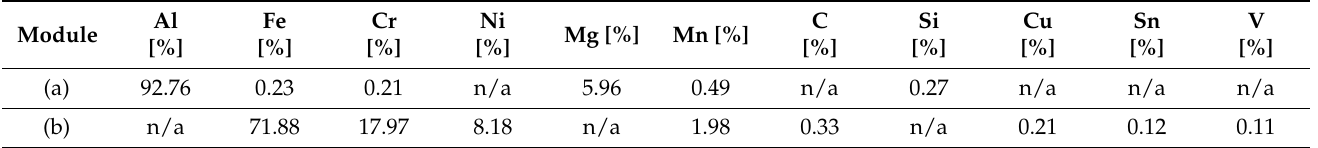
Table 4. Presentation of the results of the XRF hand-spectrometer measurements of the module housing.